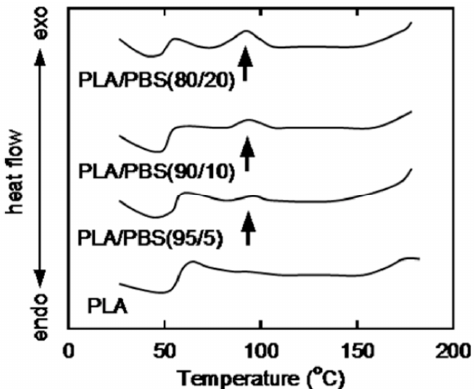
Figure 6. DSC cooling curves for PLA and PLA/PBS blends at cooling rate of 2 °C/min. The arrows in the figure indicate the crystallization peaks for PLA [22].